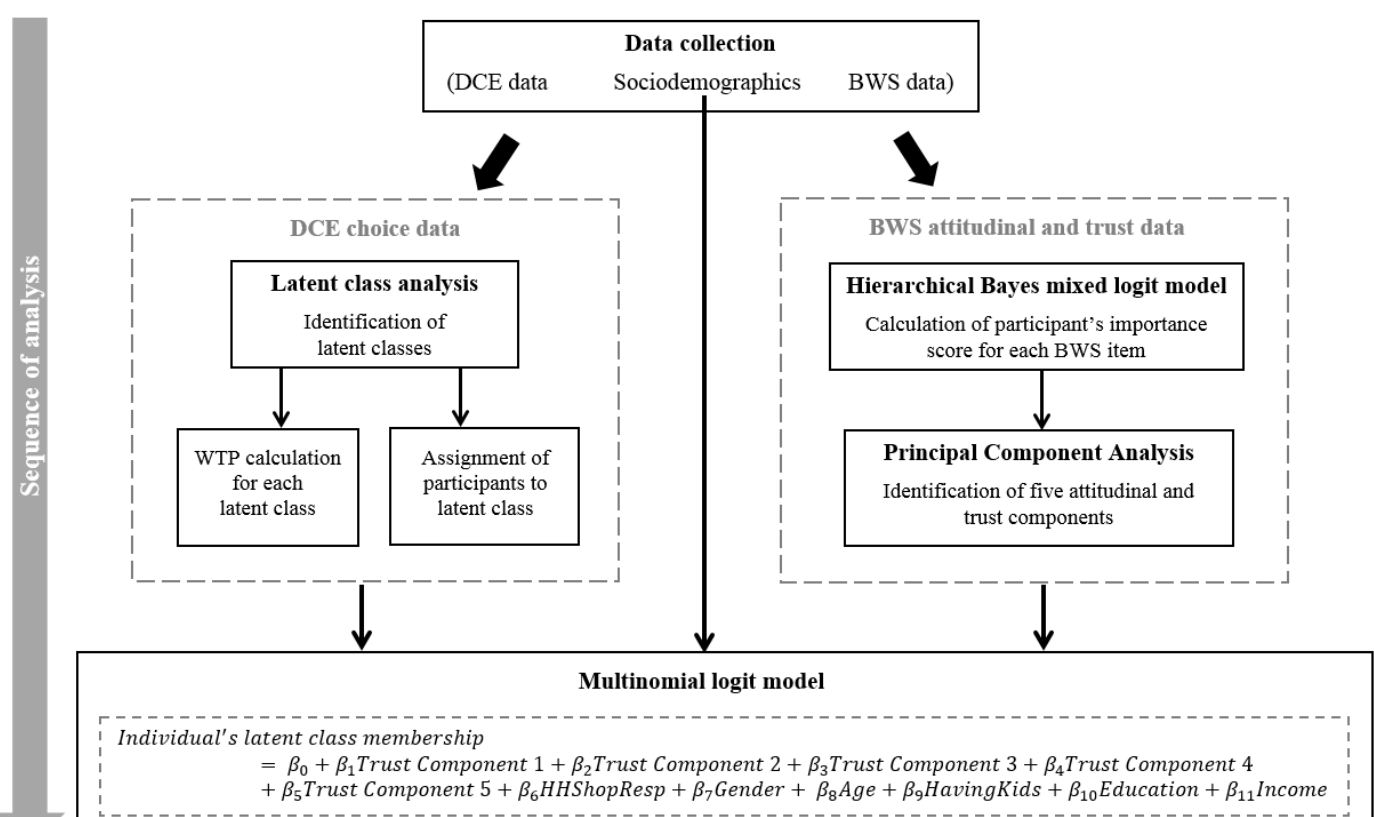
Figure 3. Research flow diagram (stepwise analysis (in the (long-format) dataset, as each individual contributed to 24 rows in the DCE data and 100 rows in the BWS data, the DCE and BWS analysis were not estimated simultaneously but sequentially. This is due to the reason that none of the exiting software, at current, is capable of estimating two different choice datasets concurrently in a model)).